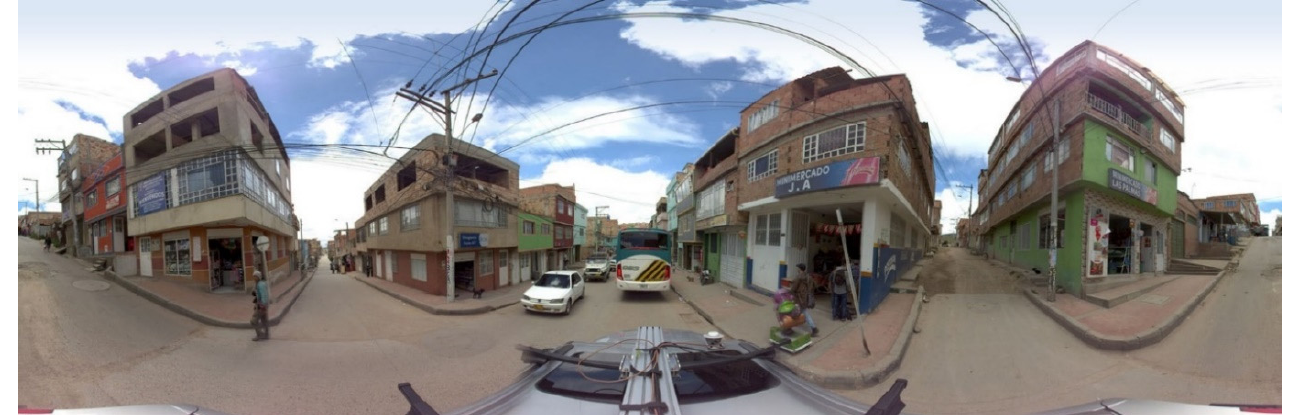
Figure 3. Street view panoramic from Colombia [source World Bank].